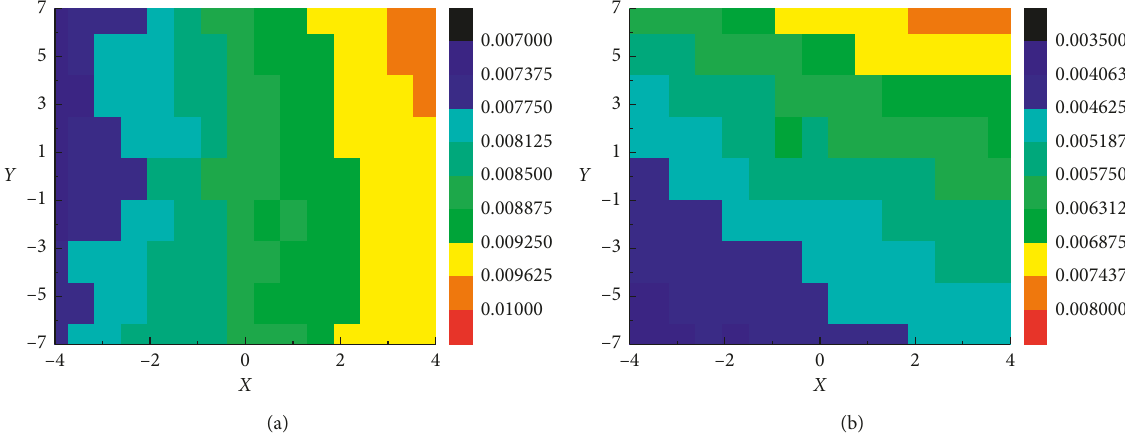
Figure 10: System response under bidirectional ground motion when primary structure is bidirectionally eccentric. (a) Displacement variance of the X direction of primary structure. (b) Displacement variance of the X direction of secondary